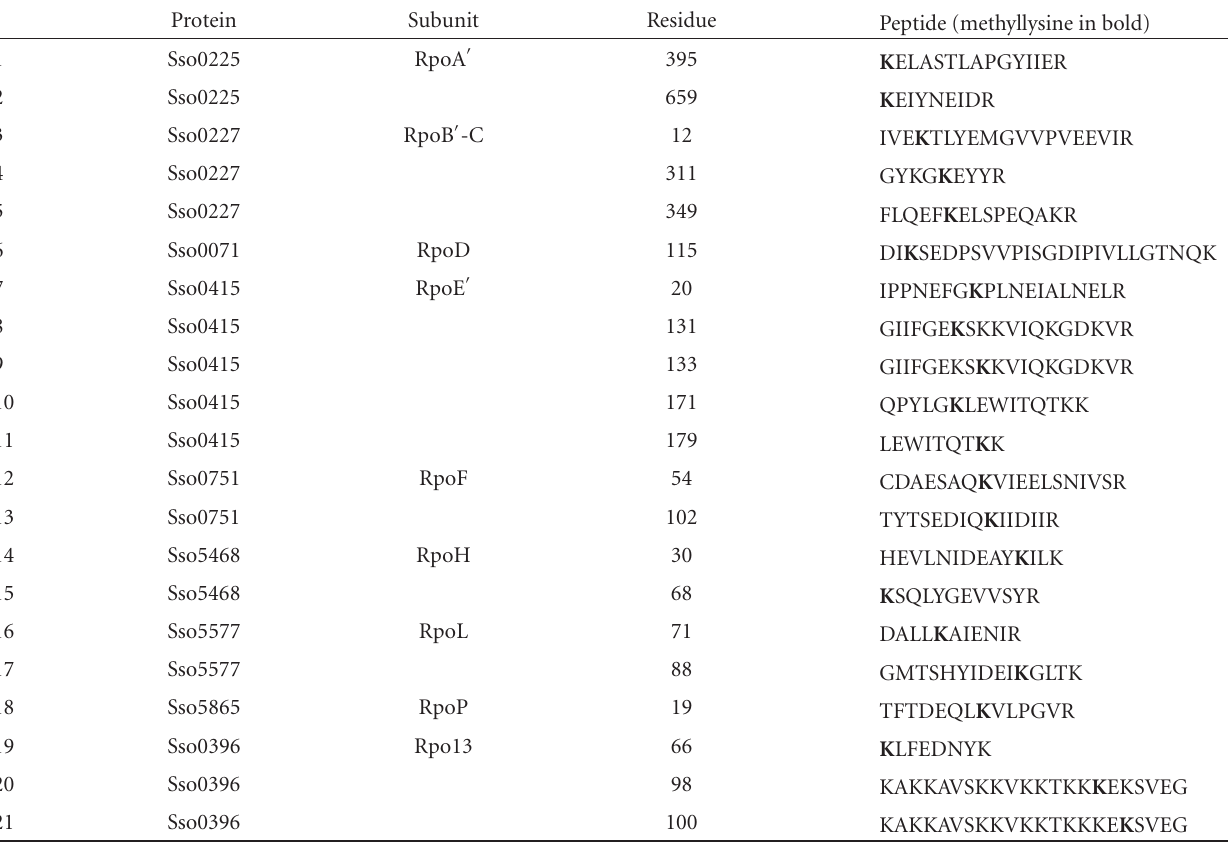
Table 1: Methylation sites identified in S. solfataricus RNA polymerase subunits † . Protein Subunit Residue Peptide (methyllysine in